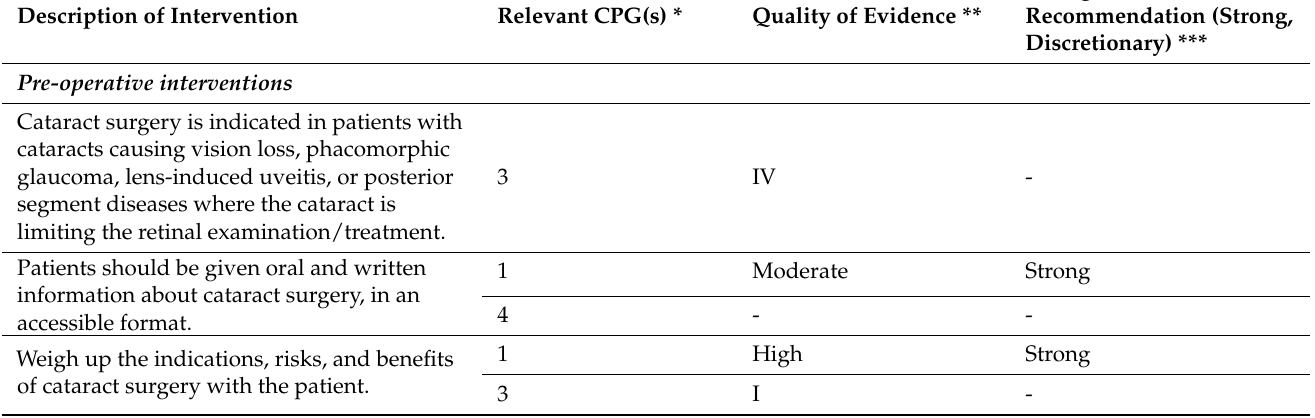
Table A1. Summary of the recommended interventions for cataract, identified from Clinical Practice Guidelines (CPGs) that met the inclusion criteria. The corresponding CPGs, highest level of quality of evidence, and the strength of recommendation are